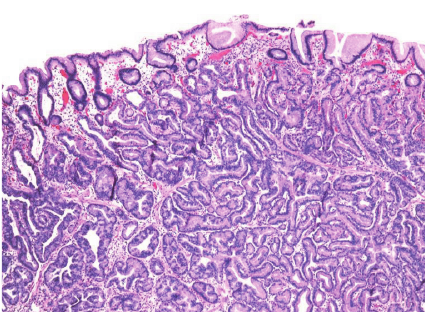
Figure 4: Occasional neoplastic cells showing oxyntic cytoplasm (H&E ×